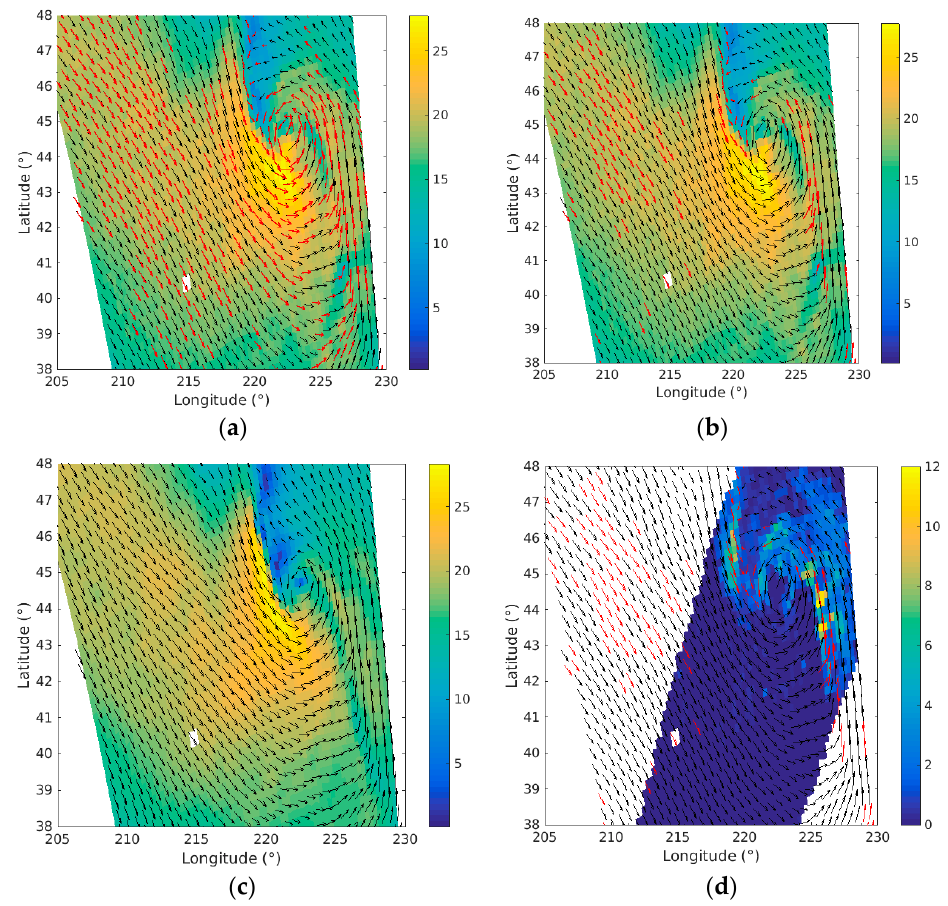
Figure 7. HSCAT-B wind vectors superimposed on the map of wind speed. Red arrows indicate the winds rejected by the operational MLE-based QC ( a ) and the proposed new QC ( b ). The ECMWF background wind field is shown in ( c ), and the collocated GMI RR is shown in ( d ). Table 4. The same as Table 2 (w.r.t. ECMWF), but using the above new QC.